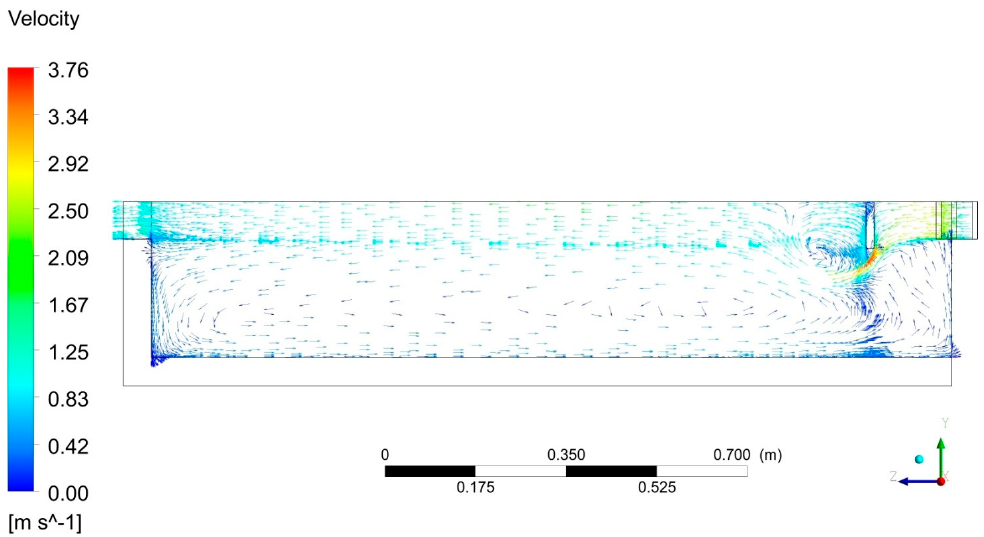
Figure 6. Visualization of the character of a flow inside a combustion chamber.